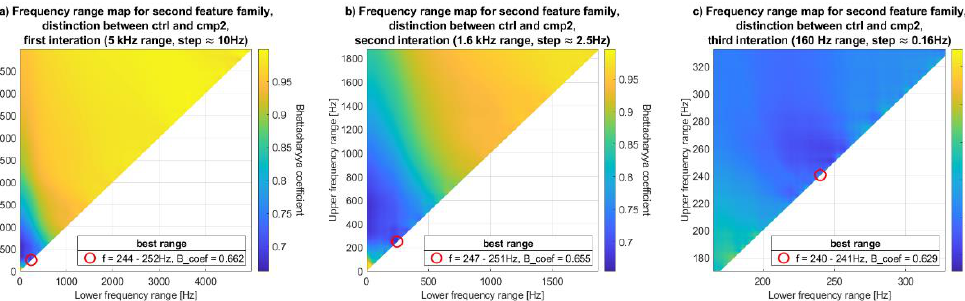
Figure 6. Three examples of the FRM; all of them were generated for the second family of features (i.e., the sum of the DFT of the derivative of the VAG signal). ( a – c ) are the consecutive iterations.